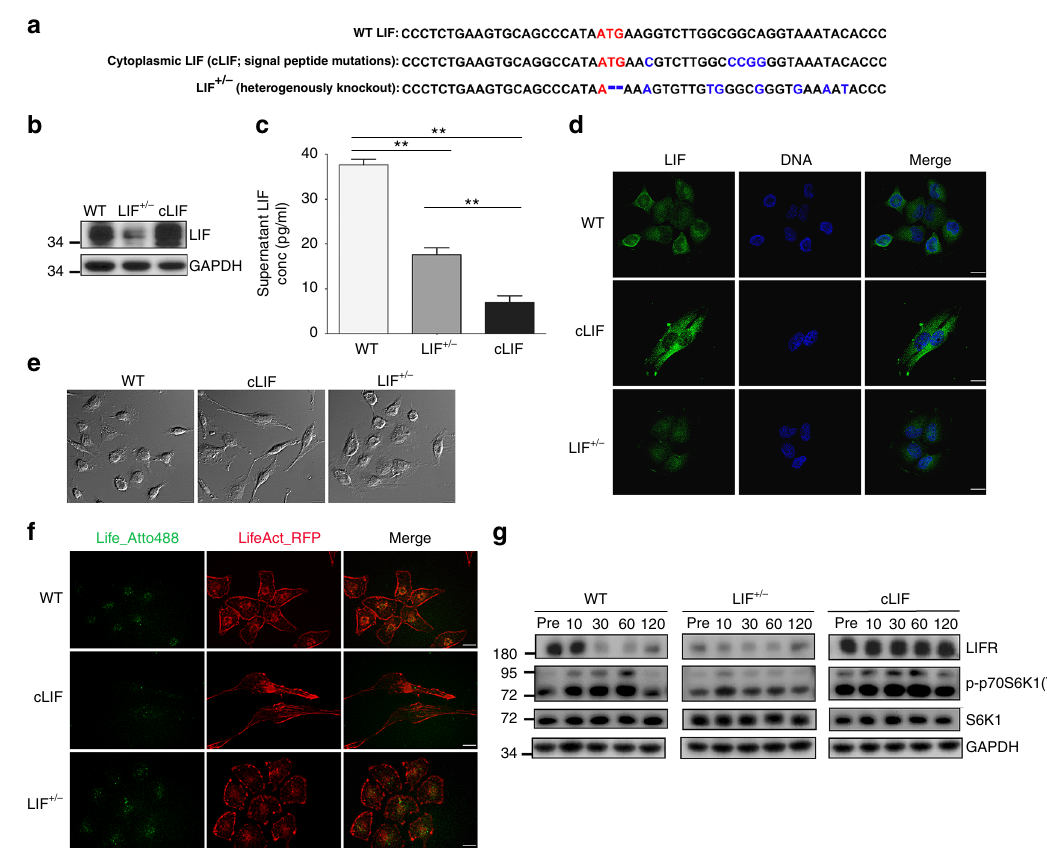
Fig. 2 Characterization of LIF mutant clones. a Sequence analysis of the LIF gene. Genomic DNA was extracted from parental NPC BM1 cells with wild-type LIF or established clones either with mutations in the signal peptide region of LIF (cLIF clone) or loss of the initiating codon in one allele (LIF + / − clone). The initiating codon within the spacer is indicated in red. Mutated nucleotides are marked in blue. b Assessment of LIF protein expression via western blot using GAPDH as a loading control. c Assessment of secreted LIF using a bead-based cytokine assay. Supernatants were harvested 2 days post culture. Data are presented as means ± SD of triplicate experiments. ** p < 0.01, two-tailed, paired t test. d Immuno fl uorescent detection of LIF (green) in WT, cLIF and LIF + / − cancer cells. Blue, nuclear staining. Scale bars, 10 μ m. e Comparison of morphological changes (DIC images) in WT, cLIF, and LIF + / − cancer cells. Scale bars, 10 μ m. f Live images of LIF uptake in cancer cells expressing LifeAct-RFP. Recombinant LIF proteins were pre-labeled with ATTO 488 green fl uorescent dye. Images were captured 40 min post-LIF addition. g Time-course analysis of LIFR desensitization and p70S6K1 activation in LIF (30 ng/ml)- stimulated cells using GAPDH as a loading (Fig. 4b). Quantitative analyses further disclosed that cLIF cells generate a two-fold increase in the invaded areas, compared to damage by WT or LIF + / − cells (Fig. 4c). To further characterize the mechanism by which intracellular LIF modulates breakdown of endothelial barriers, we utilized high-resolution time-lapse fl uorescence microscopy, which provided spatial and temporal information on the interactions between cancer and HUVEC cells. To this end, we seeded equal numbers of cancer cells expressing LiveAct-RFP into cultures of con fl uent HUVEC cells expressing LiveAct-GFP2 for live-cell imaging. As shown in Fig. 4d, LIF-rich cancer cells (cLIF) caused more signi fi cant damage to the HUVEC layer, which appeared unrepairable, compared to that induced by WT parental and LIF + / − cancer cells (Supplementary movies 4-6). Moreover, cLIF cells showed evident downregulation of endothelial junctional markers (CD31 and VE-cadherin) along the borders of the disrupted area, assessed via immuno fl uorescence staining (Fig. 4e). A single cLIF cell was capable of generating elongated protrusions and dis- rupting a wide range of endothelial junctions. Data from western blot analyses also showed decreased expression of CD31 and VE- cadherin in cLIF cells (Fig. 4f), but not WT and LIF + / − groups. This fi nding may be attributable to the fact that only a limited number of cancer cells were co-cultivated with HUVEC cells.